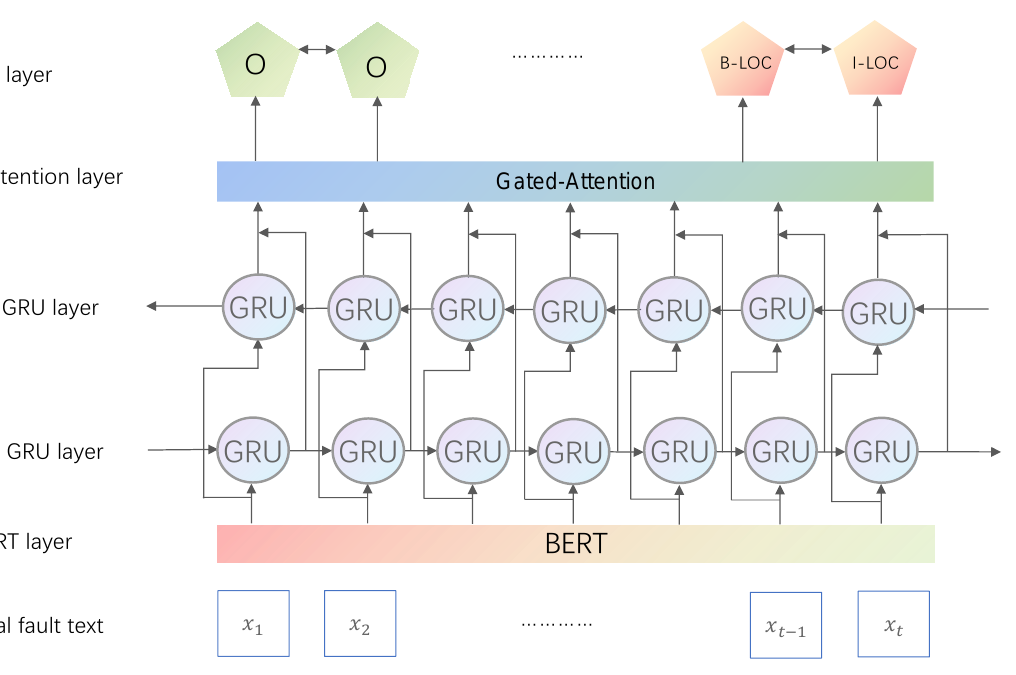
Figure 5. BBiGRU-GA-CRF entity extraction model.